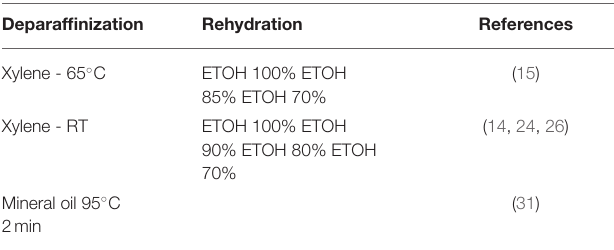
TABLE 1 | Deparaffinization methods reported in the literature that were followed in the present work. While in the deparaffinization with xylene (at 65 ◦ C and RT) is